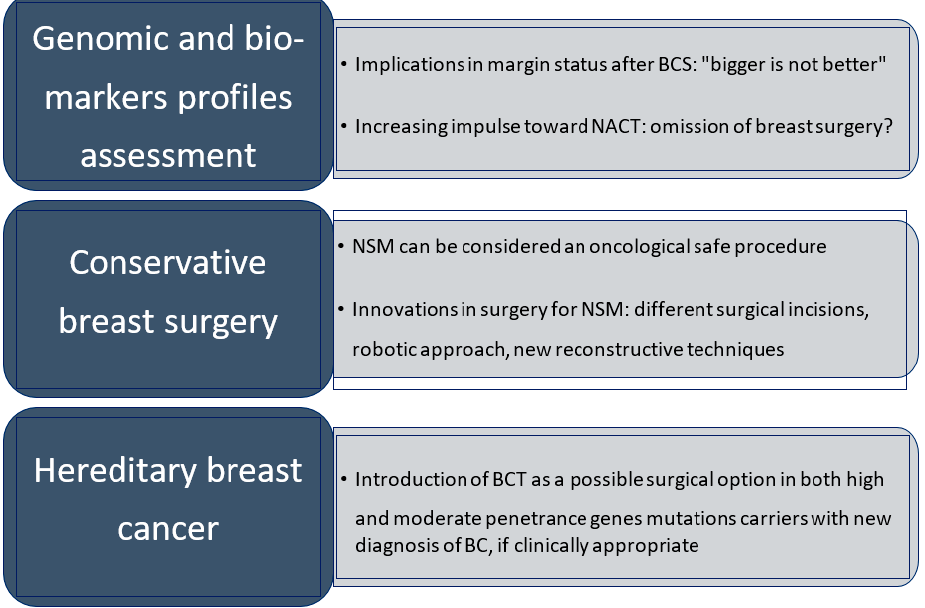
Figure 2. Last three decades’ advances in de-escalating BC surgery. BCS: breast conservative surgery; NACT: neo-adjuvant chemotherapy; NSM: nipple sparing mastectomy; BC: breast cancer.